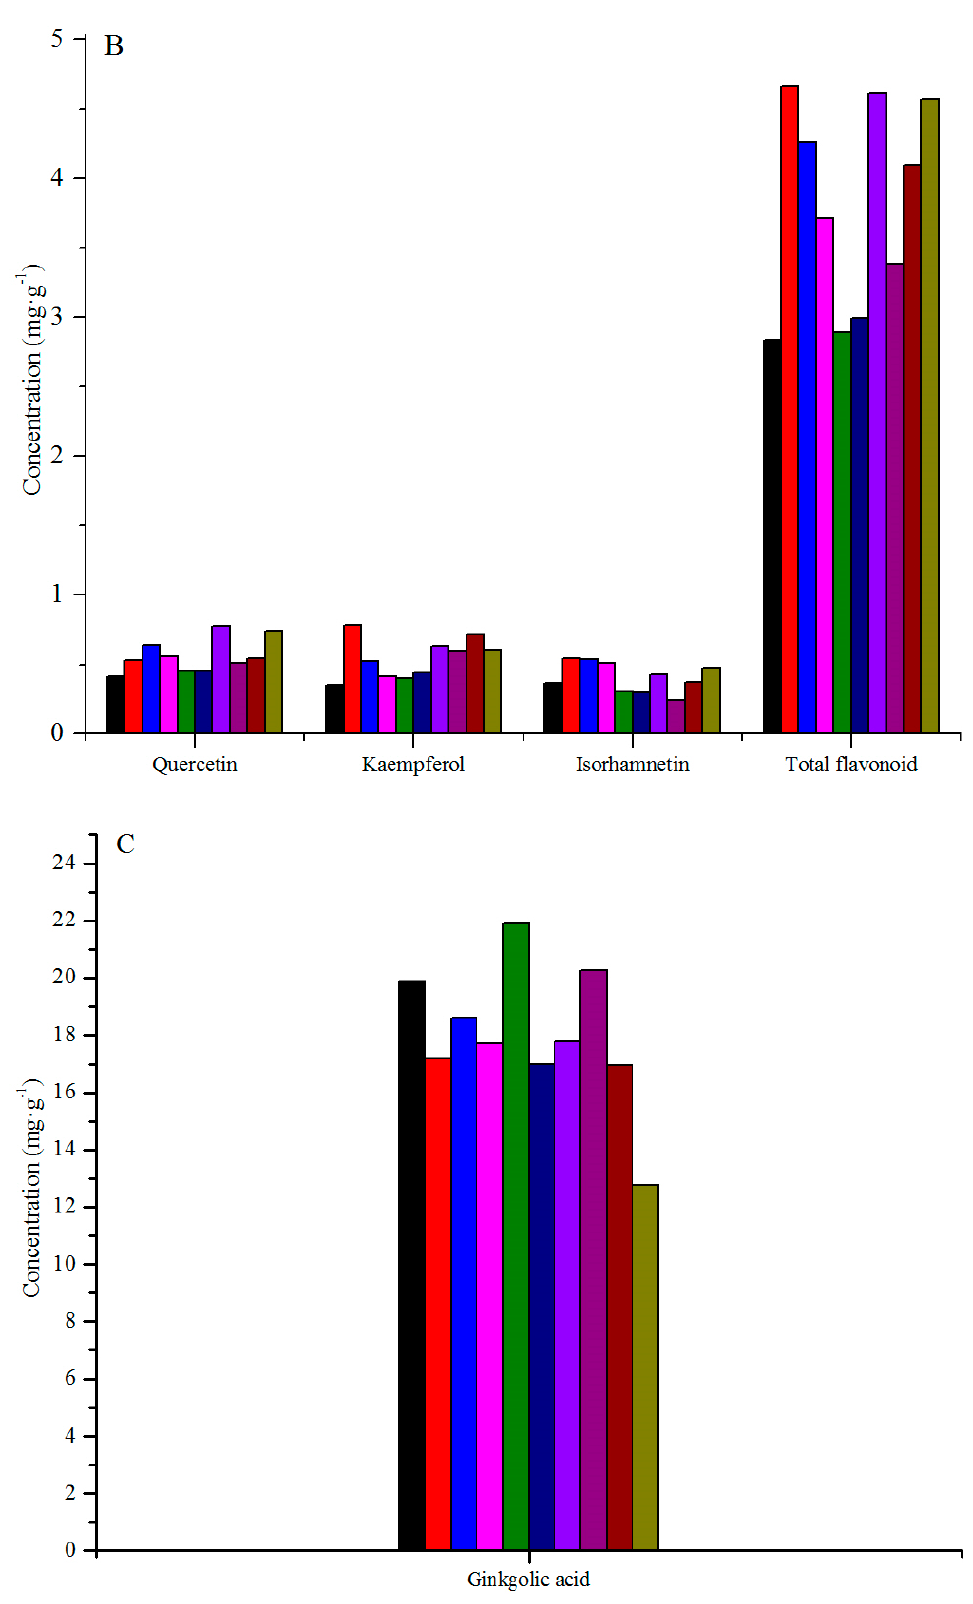
Figure 2. Concentrations of lactones ( A ), flavonoids ( B ), ginkgolic acid ( C ) in dry leaves from ten populations. The data represent mean concentrations of three types of secondary metabolites (SMs).